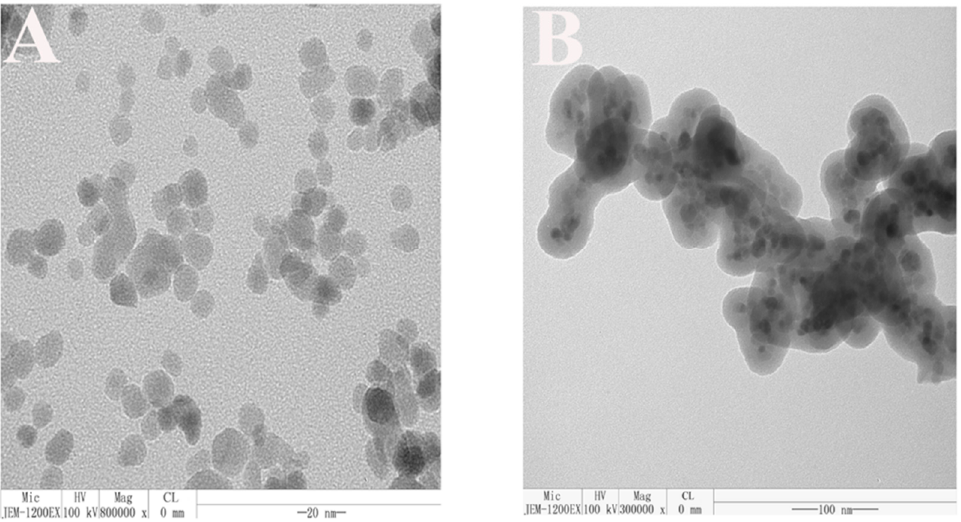
Figure 2. Transmission electron microscopy pictures of Fe 3 O 4 ( A ) and Fe 3 O 4 / SiO 2 ( B ) particles.